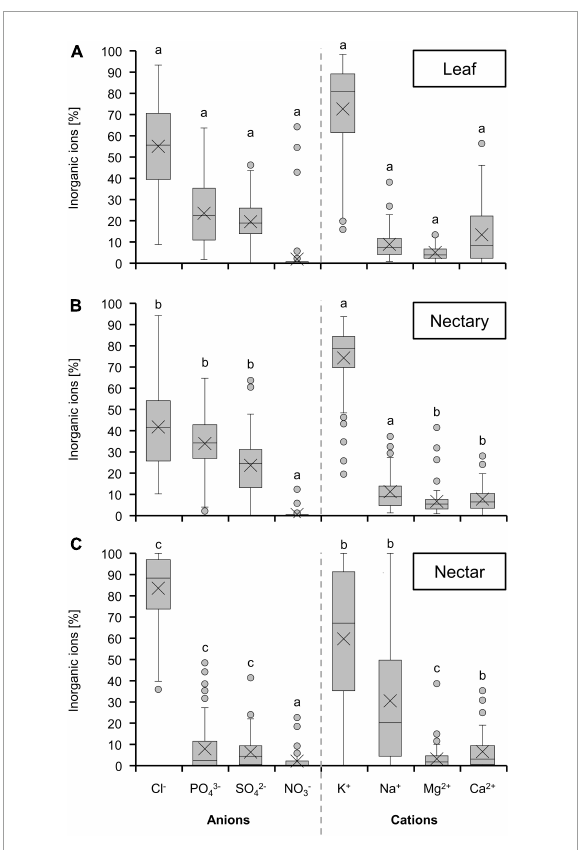
FIGURE5 Percentage of different inorganic ions in leaf (A) nectary (B) and nectar (C) . The shown data includes all 36 bromeliad species ( n = 3). Different letters represent significant differences in individual amino acids between leaf, nectary and nectar (Tukey’s HSD; p <